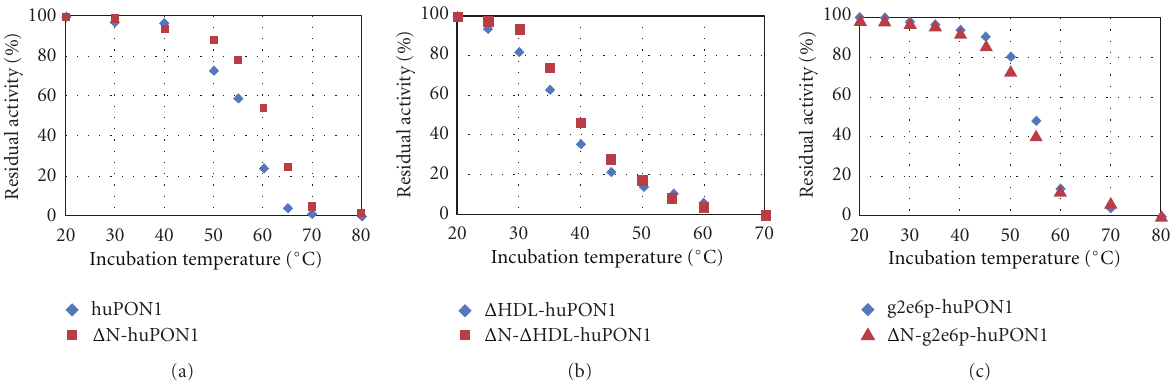
Figure 7: Stability of huPON1 variants. The residual activities against phenyl acetate after 10 min of incubation at the indicated temperatures are shown. The residual activity after incubation at 20 ◦ C was taken as 100%. (a) huPON1 and Δ N-huPON1; (b) Δ HDL-huPON1 and Δ N- Δ HDL-huPON1; (c) g2e6p-huPON1 and Δ N-g2e6p-huPON1.